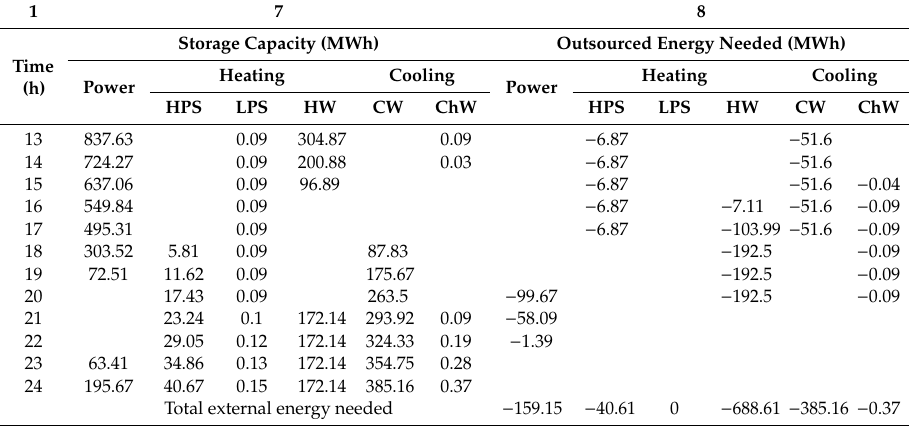
Table A18. TriGenSCT of final trigeneration PWR NPP with integration from time 13 to 24